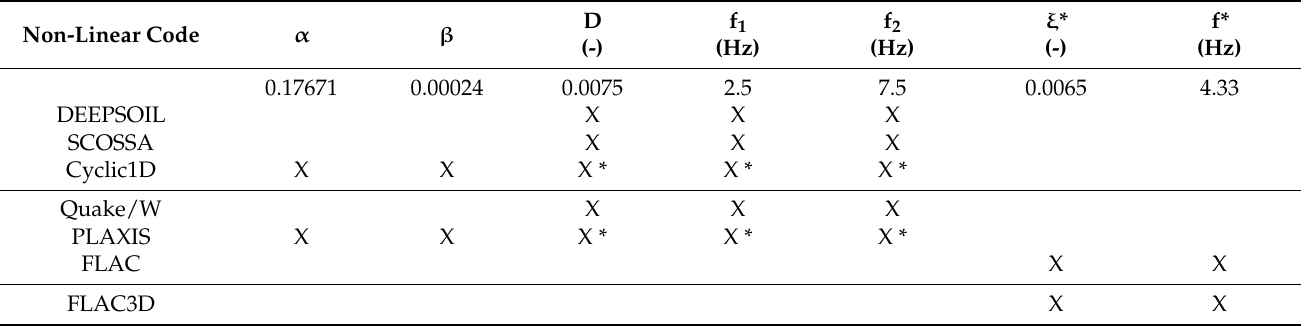
Table 2. Parameters of the Rayleigh damping with identification of the input variables requested by the different non-linear